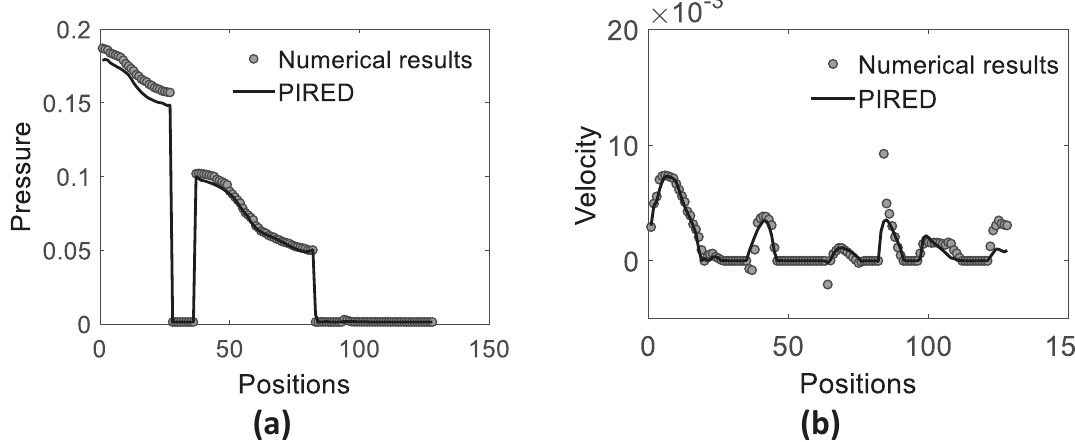
Fig. 5 Quantitative comparison of the PIRED predictions with the direct numerical results. Comparison of predicted ( a ) pressures and ( b ) fl uid velocities with the numerical simulations in a randomly selected 2D image along a line perpendicular to the macroscopic direction of fl